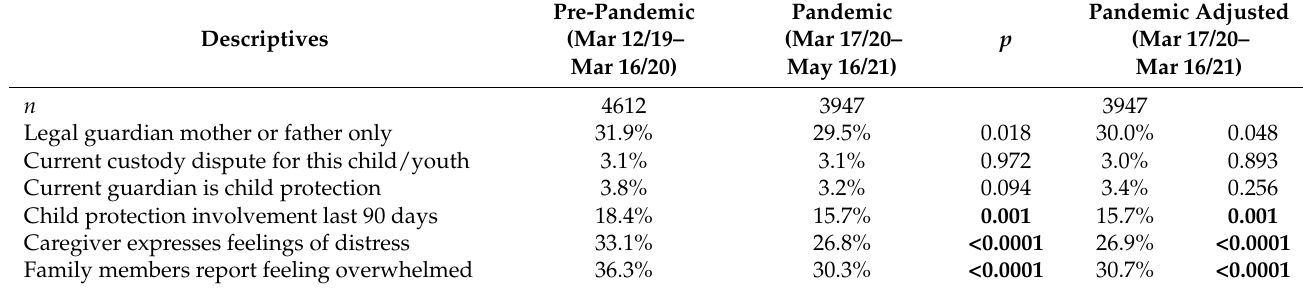
Table 2. Selected descriptive characteristics, by year, with and without